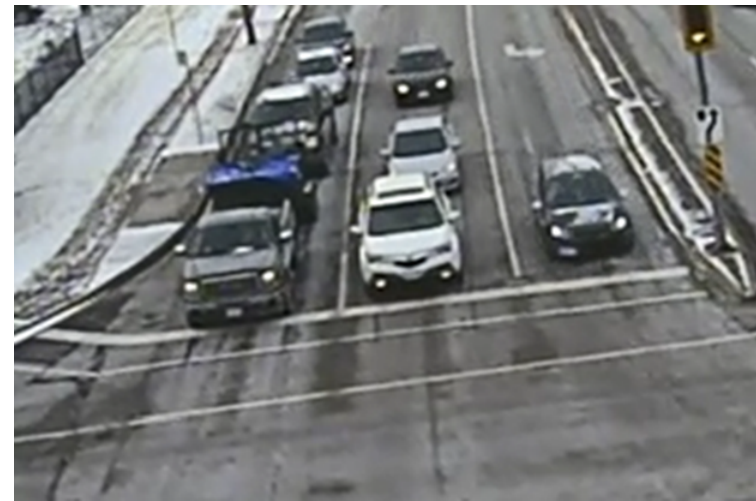
Figure 1. Vehicle queue at an